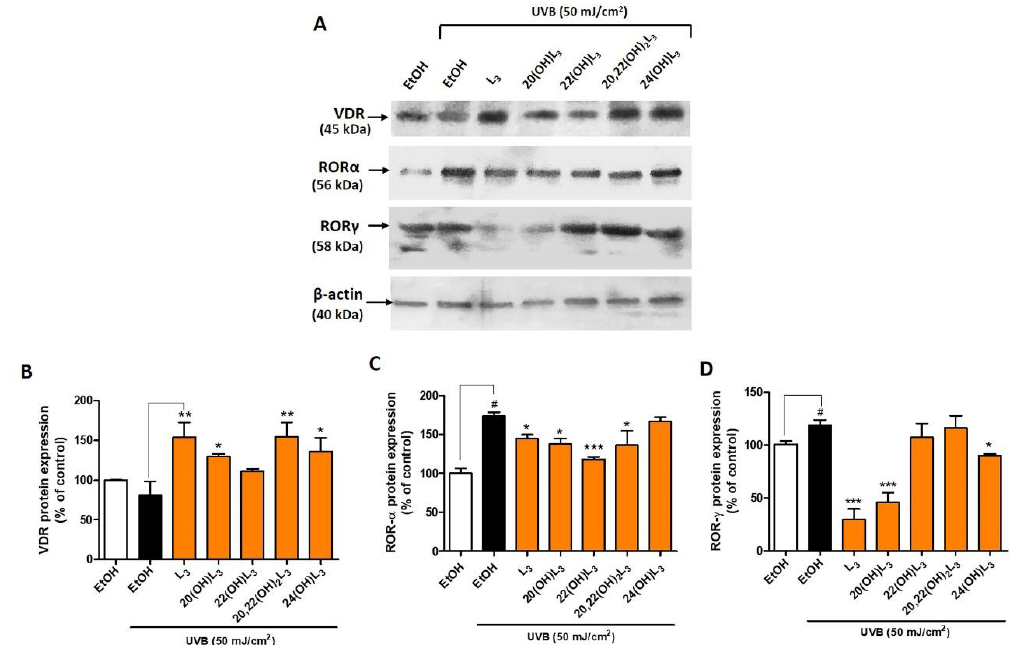
Figure 3. Changes in VDR and ROR protein expression in keratinocytes treated with L3 derivatives following UVB irradiation. Keratinocytes were pretreated with secosteroids (100 nM) or ethanol for 24 h before UVB irradiation (50 mJ/cm 2 ) and then further incubated with the secosteroids for an additional 24 h. ( A ) Representative Western blots and ( B – D ) the densitometric analysis of protein expression shown as bar graphs. ( B ) VDR, detected at 45 kDa, ( C ) RORα, detected at 56 kDa, and ( D ) RORγ, detected at 58 kDa size by Western blotting. The protein levels were normalized relative to β -actin and presented as % of control and averaged from three-independent experiments (mean ± SD). The statistical analysis between the non-irradiated control (white bar) and UVB-irradiated cells (black bar) was calculated by Student’s t -test, and between UVB-irradiated control and lumisterol-treated cells (dark orange bars) by one-way ANOVA with Dunnett’s multiple comparison test. # p < 0.05 versus non-irradiated control cells and * p < 0.05, ** p < 0.01 and *** p < 0.001 versus irradiated and untreated cells.